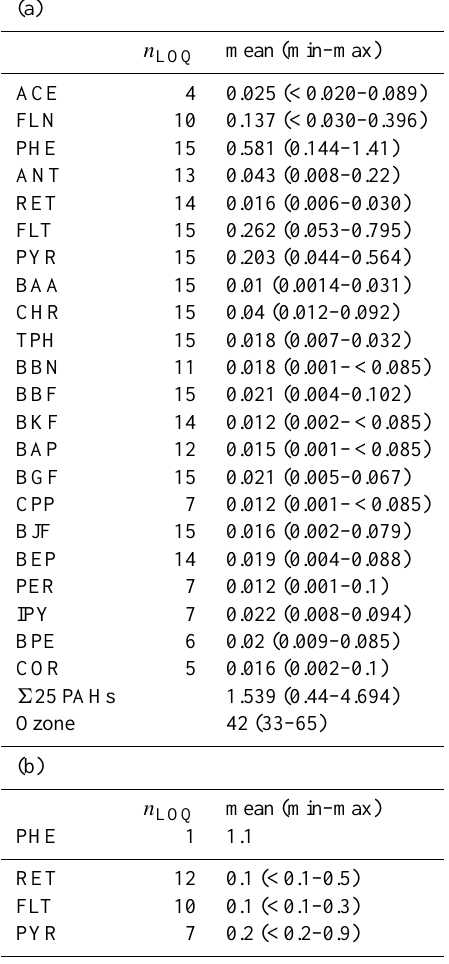
Table 1. Concentrations of PAHs found in (a) air (total, i.e. sum of gas and particulate phases, ngm − 3 ) and (b) seawater (total, i.e. sum of dissolved and particulate, ngL − 1 ) as time-weighted mean (min–max). n LOQ represents number of samples >LOQ (out of 15 air and 23 seawater samples). PAHs with concentrations <LOQ in all samples not listed. For calculation of means, values <LOQ were replaced by LOQ/2. Ozone levels are given, too